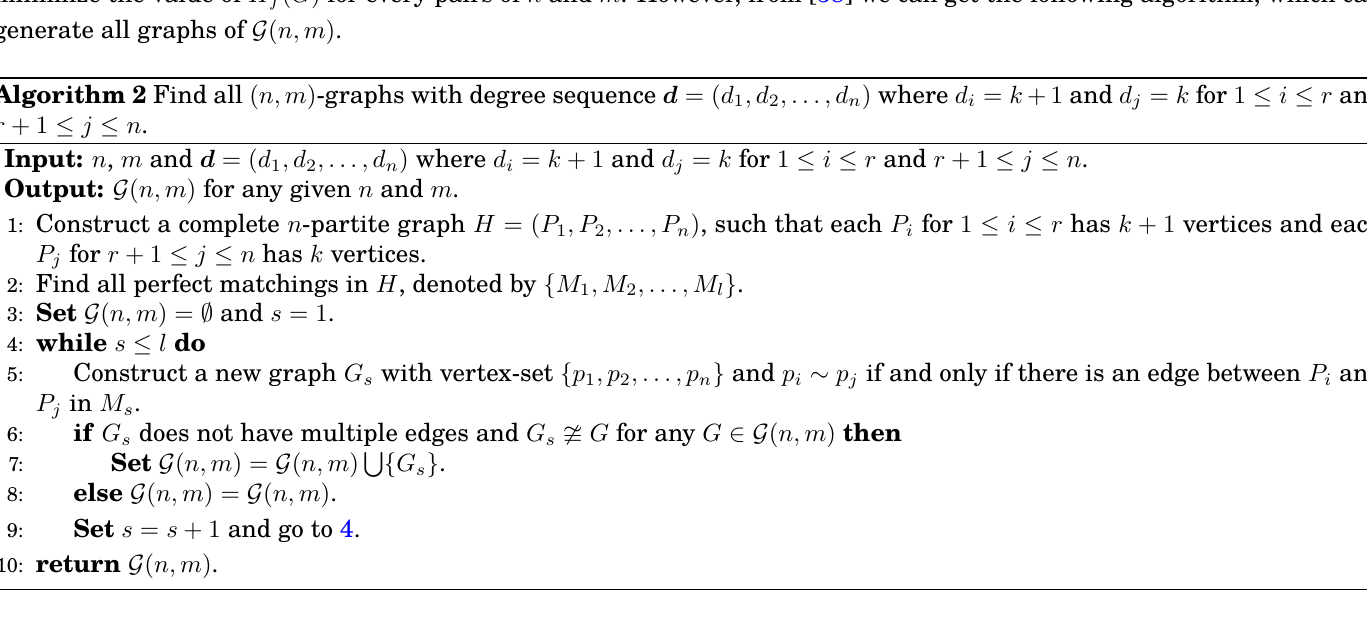
Algorithm 2 Find all ( n, m ) -graphs with degree sequence d = ( d 1 , d 2 , . . . , d n ) where d i = k + 1 and d j = k for 1 ≤ i ≤ r and r + 1 ≤ j ≤ n .